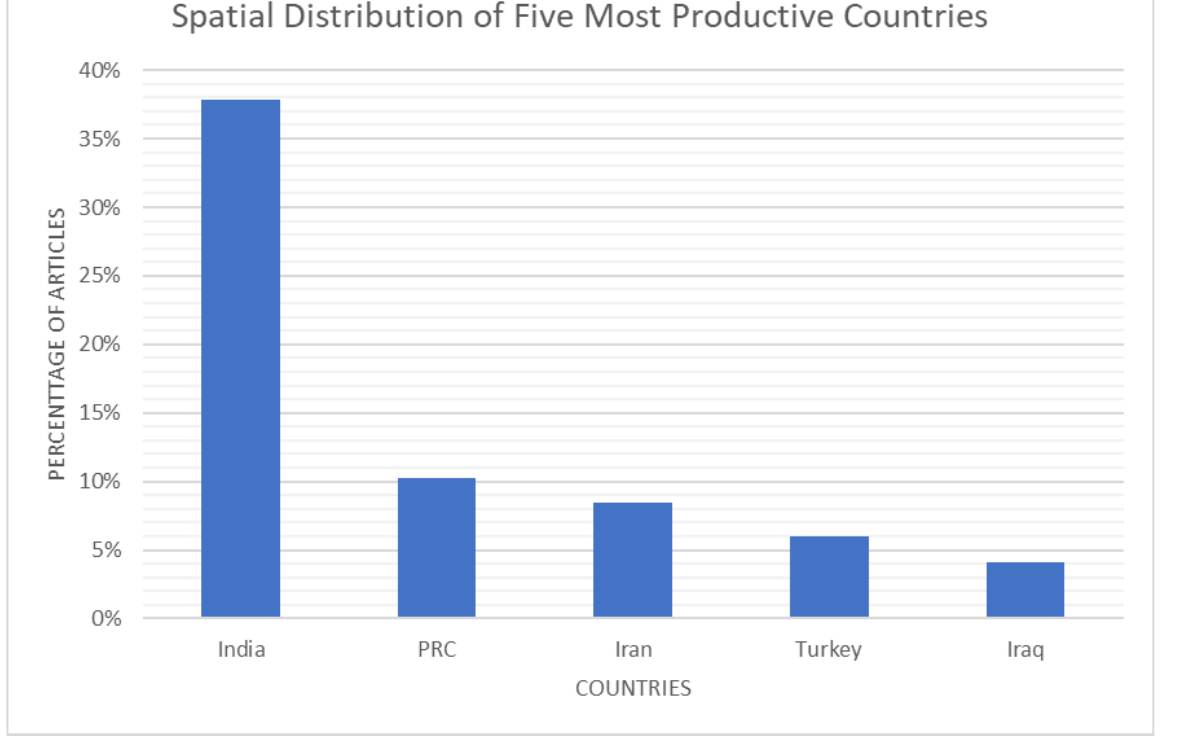
Figure 5. Spatial distribution of the most productive countries in SAHs.